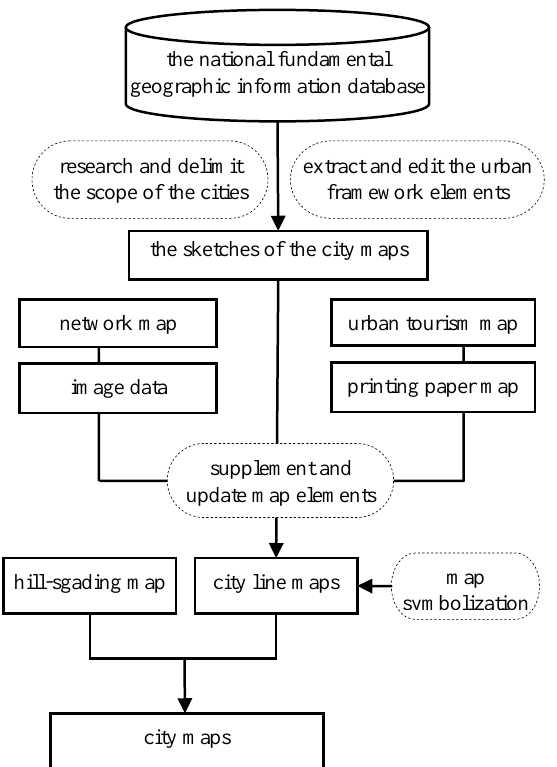
Figure 3. Technical process and method of compiling city maps